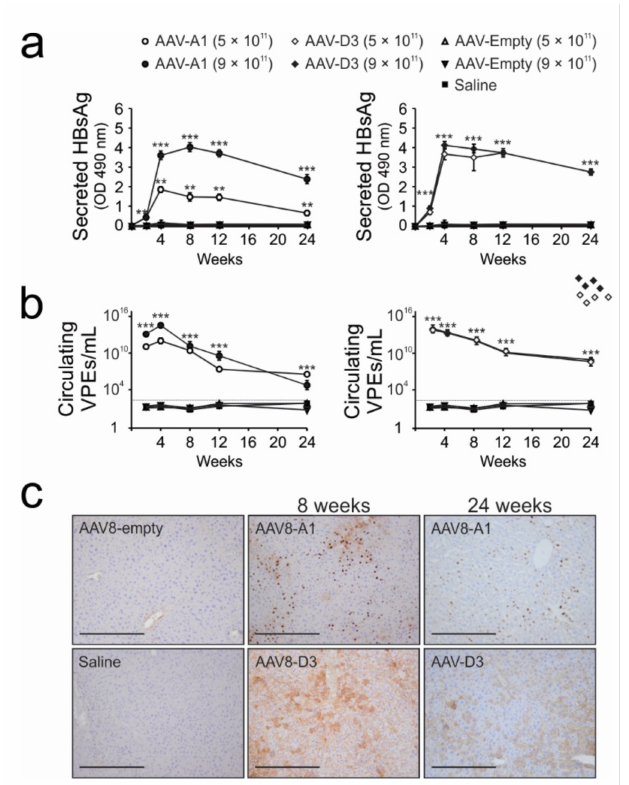
Figure 3. Evaluation of long-term HBV gene expression and replication in vivo. ( a ), HBsAg levels in serum collected from mice treated with saline or AAVs. Means and SEMs were calculated from data obtained from 8 mice per group. ( b ), serum concentrations of HBV VPEs after injection of mice with saline or AAVs. Values represent the means and SEMs calculated from data obtained from 4 mice per group. Statistically significant differences between samples were calculated using the Student’s two-tailed paired t -test. p values of ≤ 0.01 (**) and ≤ 0.001 (***) were considered statistically significant. ( c ), representative images showing HBcAg-immuno-positive hepatocytes in mice at 8 and 24 weeks after treatment with saline or AAVs at a dose of 9 × 10 11 VPEs per mouse. Staining was performed on tissue sections from 3 mice per group. Brown stain shows HBcAg-positive cells at 10 × magnification. Low-power fields with scale bars of 200 µ m are